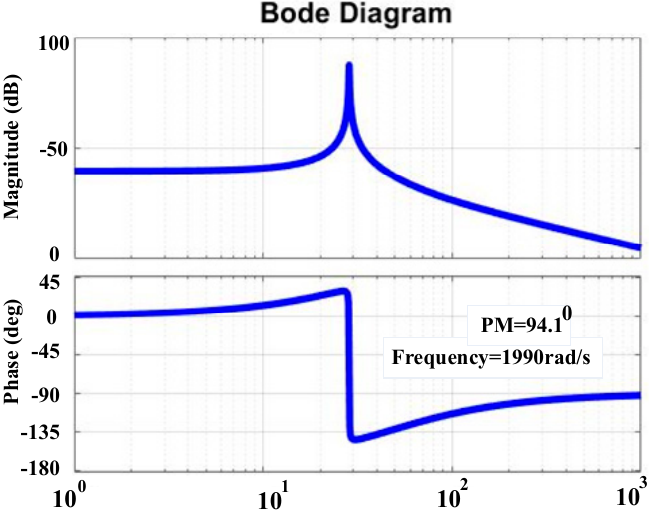
= 94.1 ◦ at 1990 rad /